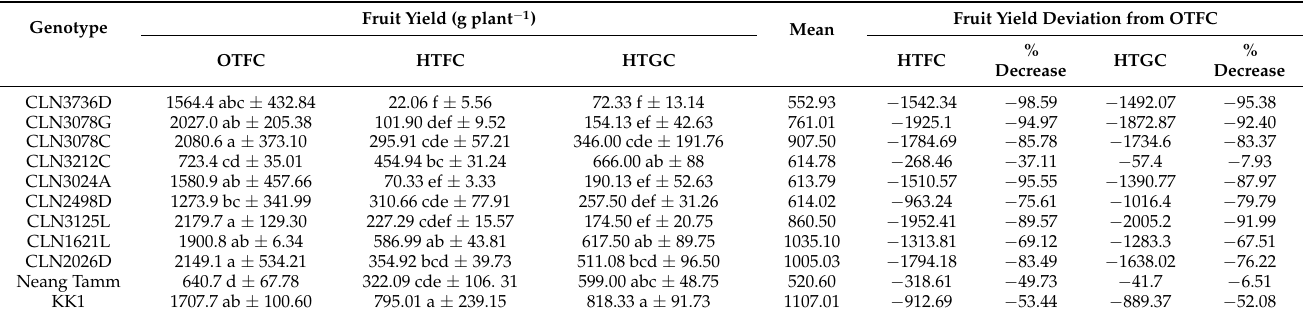
Table 4. Mean fruit yield of genotypes under optimal temperature field condition (OTFC), high temperature field condition (HTFC) and high temperature greenhouse condition (HTGC), and mean fruit yield deviation from